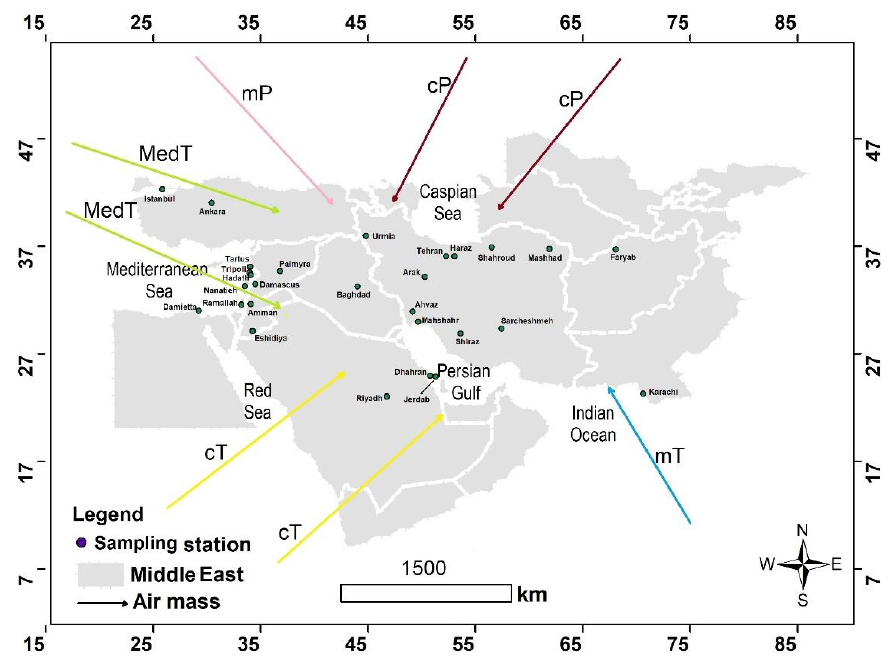
Figure 1. The studied stations and main air masses affecting the Middle East. Air mass flux and moisture sources have also been studied using vertically integrated moisture flux (VIMF) (Figure 2). The northward and eastward data of the vertically integrated moisture flux from ERA-Interim reanalysis [50] with a resolution of 1° × 1° were utilized in this study. ERA-Interim reanalysis belongs to the European Center for Medium-Range Weather Forecast (ECMWF). During the dry period (May to October) in the Middle East, a notable VIMF can be observed over the Indian Ocean and the Arabian Sea. During this period, the VIMF divergence can also be seen at degrees higher than 40 °N. In contrast, during the wet period (from November to April), the VIMF convergence prevails over the Middle East and causes precipitation. During this period, moisture mainly originates from the Mediterranean Sea, the Black Sea, the Persian Gulf, and the Arabian Sea. This is in close agreement with previous studies [51,52].